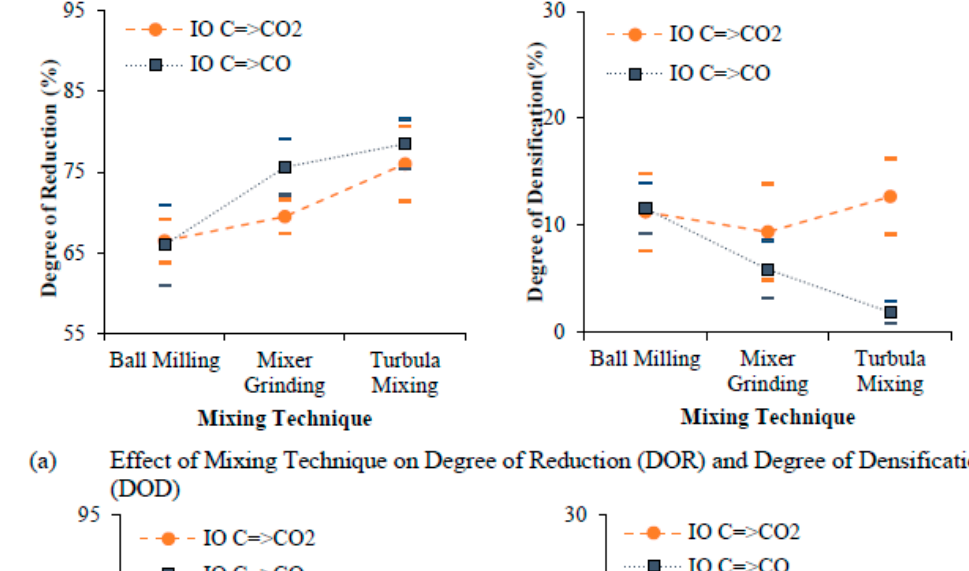
Figure 11. Effect of interaction of material parameters on DOR and DOD.